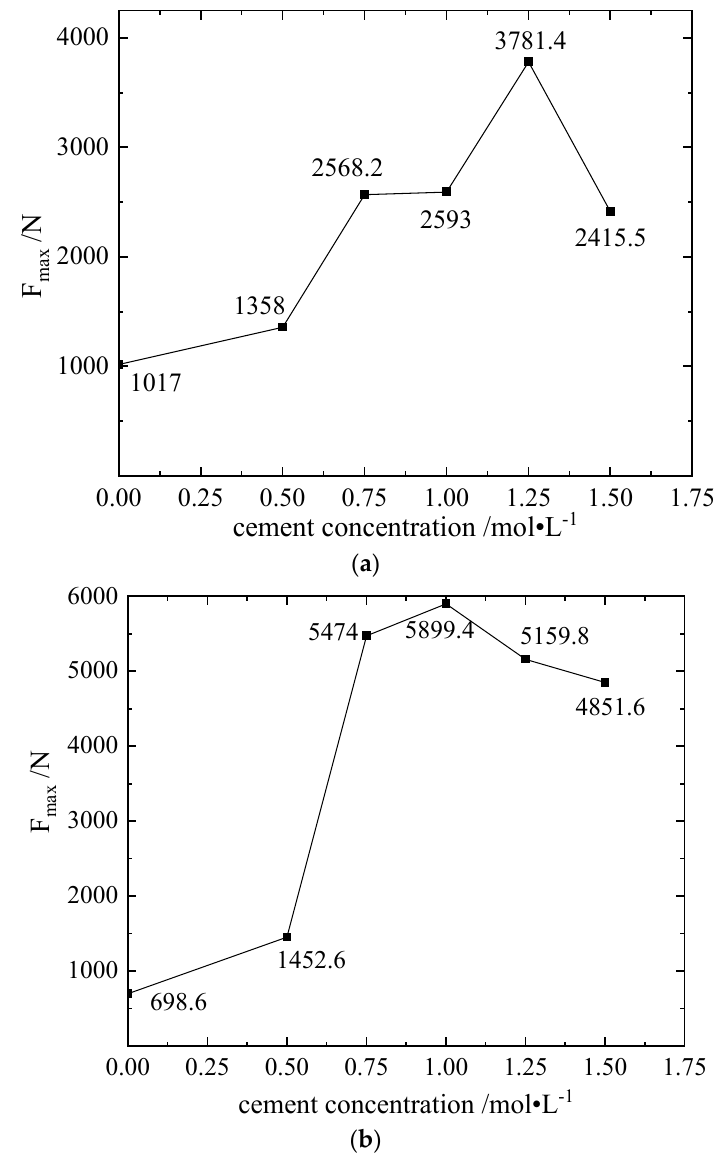
Figure 2. Concentration of cementitious liquid and maximum axial force Fmax of different samples in scheme E. ( a ) Concentration and F max diagram of cementitious solution of constant humidity sample in Scheme E. ( b ) Figure of the concentration and maximum axial force F max of the soaking sample in Scheme E.